Question: Summarize what this figure shows in one sentence.
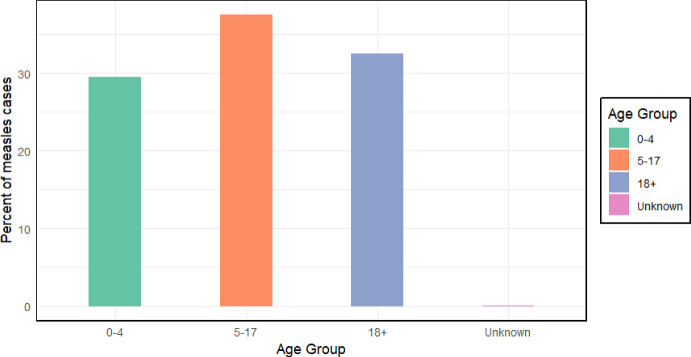
Answer: Percentage of measles cases in Texas by age for the year 2025